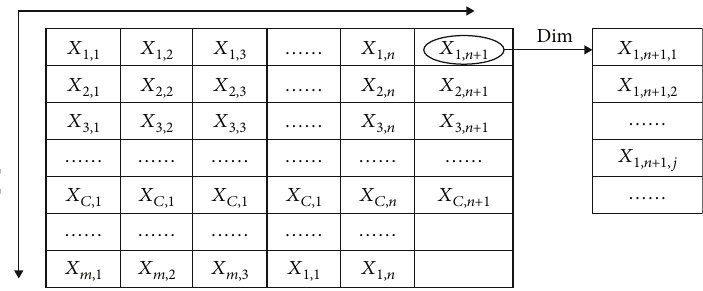
Figure 1: Individual distribution in multiple